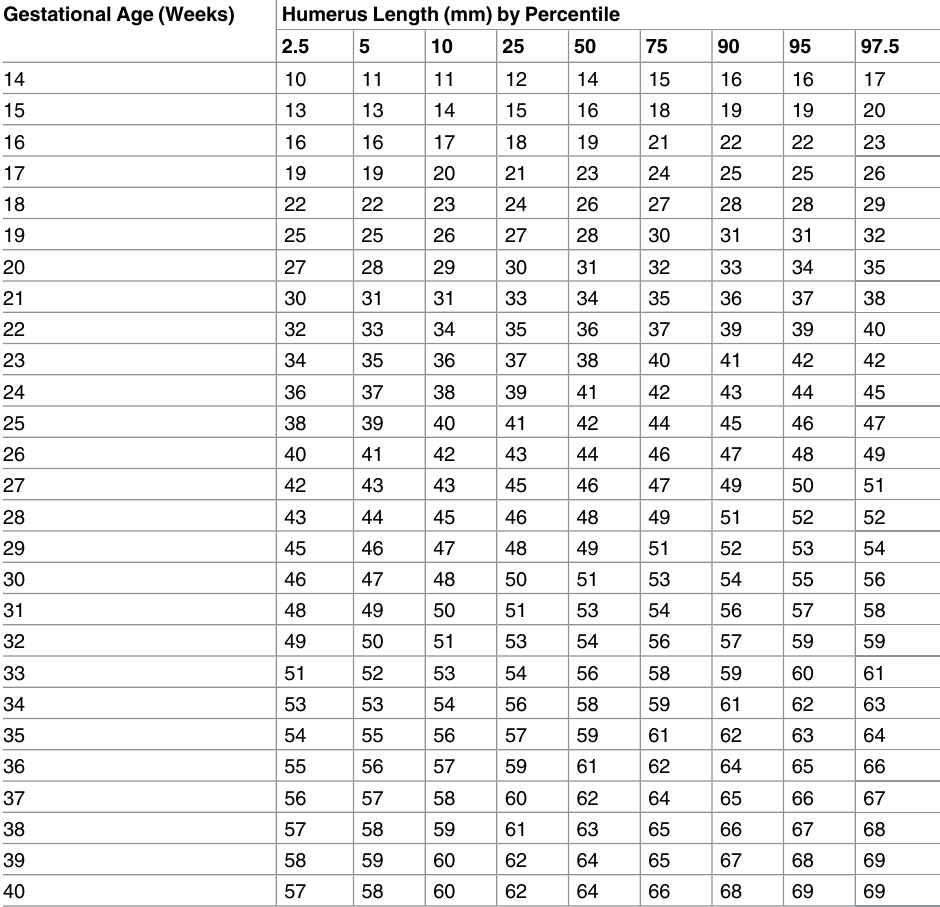
Table 10. Growth chart for fetal humerus